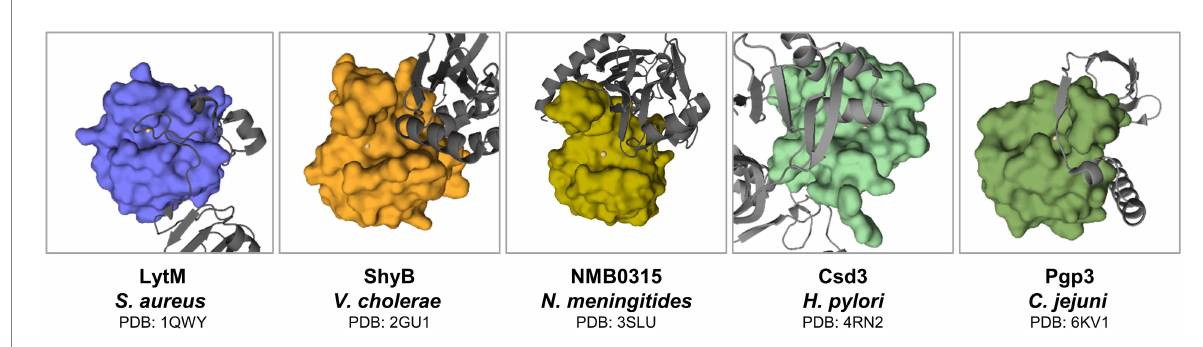
FIGURE 6 Latency forms of M23 peptidases. Regions that protrude from the active site are indicated in gray. M23 domains were defined accordingly in literature (Odintsov et al., 2004; Ragumani et al., 2008; Wang et al., 2011; Min et al., 2020) as depicted in surface representation. Active site metals are presented as